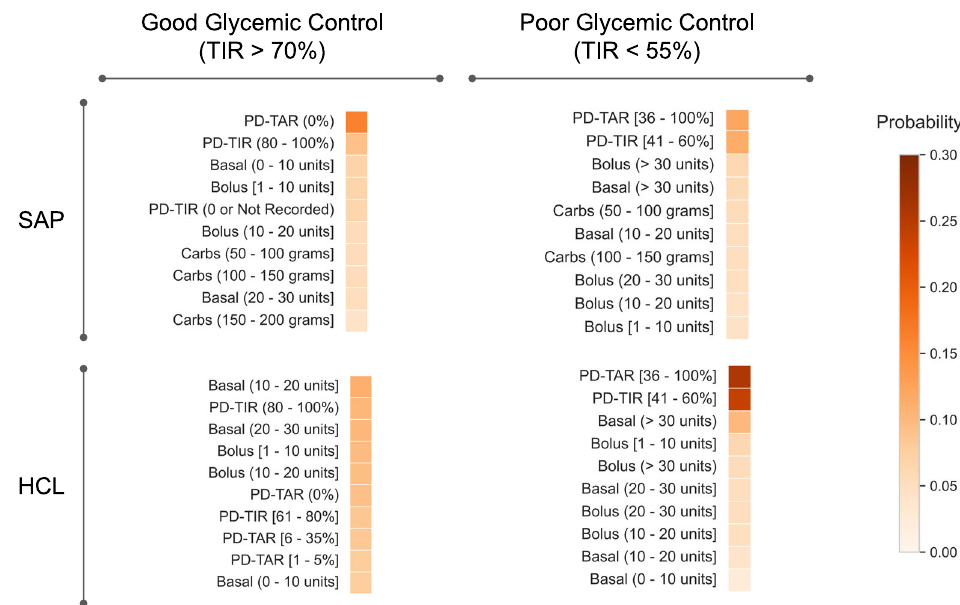
Fig. 3 Top 10 digital biomarkers associated with good and poor glycemic control for the SAP and HCL datasets. This fi gure shows the probabilities obtained from modeling the de fi ned objective features and daily glycemic control using